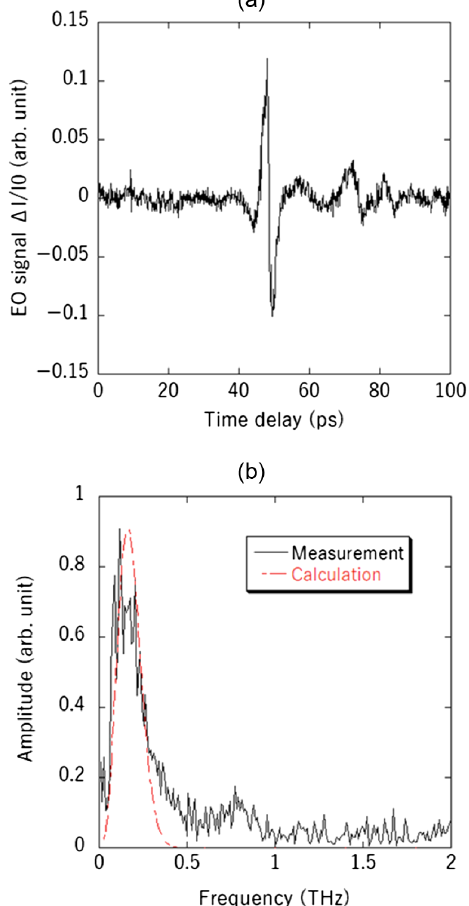
10. (a) Electric field waveform of a CChR pulse obtained by EO sampling and (b) its Fourier transform, calculated with a beam size of 400 μ m and a bunch length of 2.5